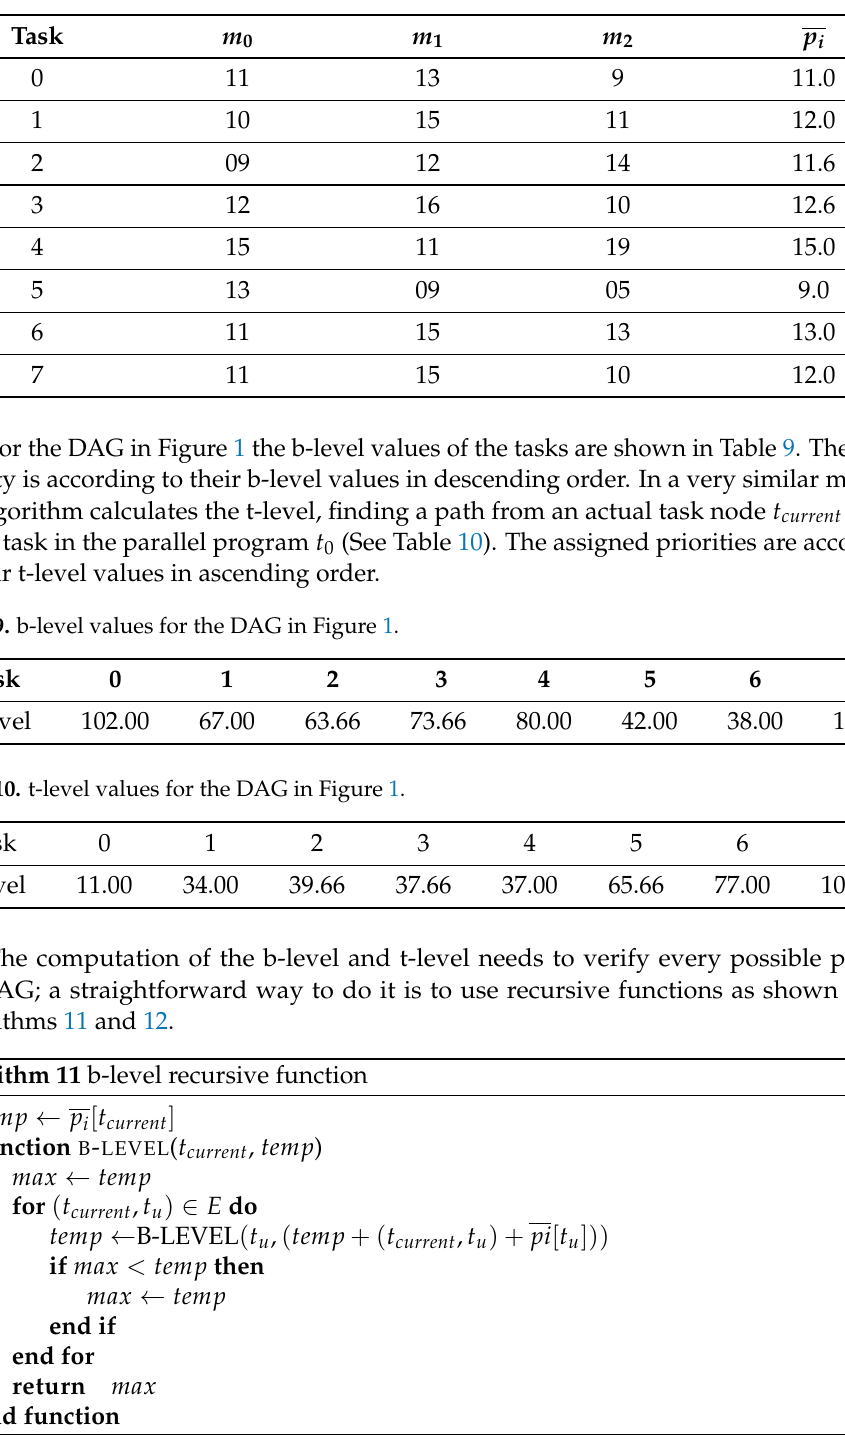
Table 8. Mean values of the tasks computing times.